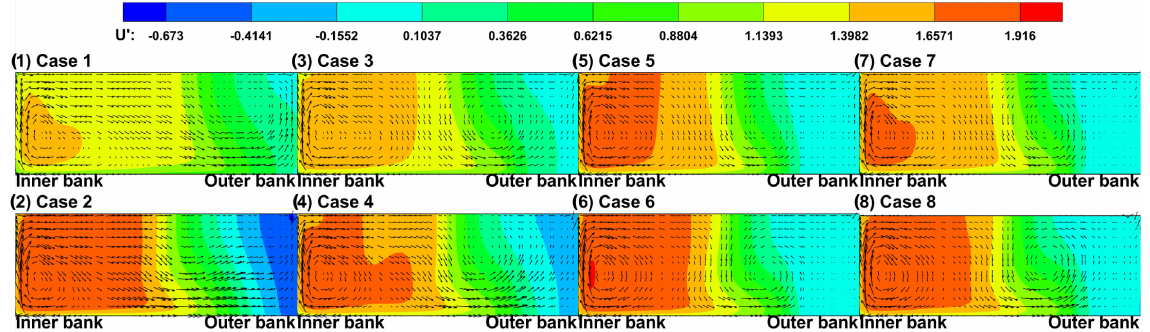
Figure 12. The contours of dimensionless streamwise velocity distribution and 2 ‐ D vectors on CS. 1 of all the cases.